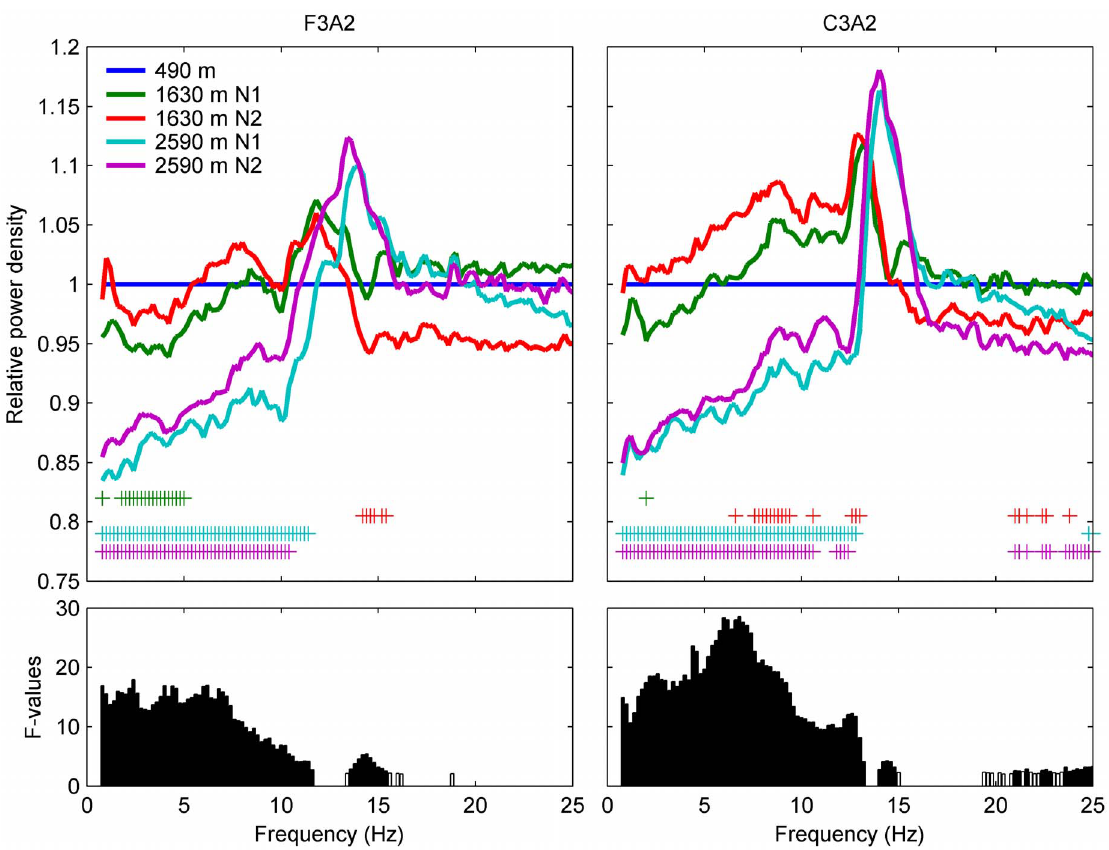
Figure 1. Relative non-REM sleep EEG power density spectra at moderate altitude. Upper panels: Spectra at altitude (1630 m and 2590 m, N1 [first night] and N2 [second night]) are plotted relative to baseline sleep (490 m; line at 1). Significant differences (p , 0.05, post-hoc paired t-test) between baseline and altitude are indicated by ‘‘ + ’’ (n=44). Frequency resolution: 0.2 Hz. Lower panels: F-values of the frequency bins with significant p-values for factor Condition (490 m N1, 1630 m N1, 1630 m N2, 2590 m N1 and 2590 m N2) of mixed model ANOVA with factors Condition and Order . F3A2: frontal derivation; C3A2: central derivation. Due to technical problems during N2 at 2590 m, the EEG data of two subjects were incomplete and these two nights were excluded from the